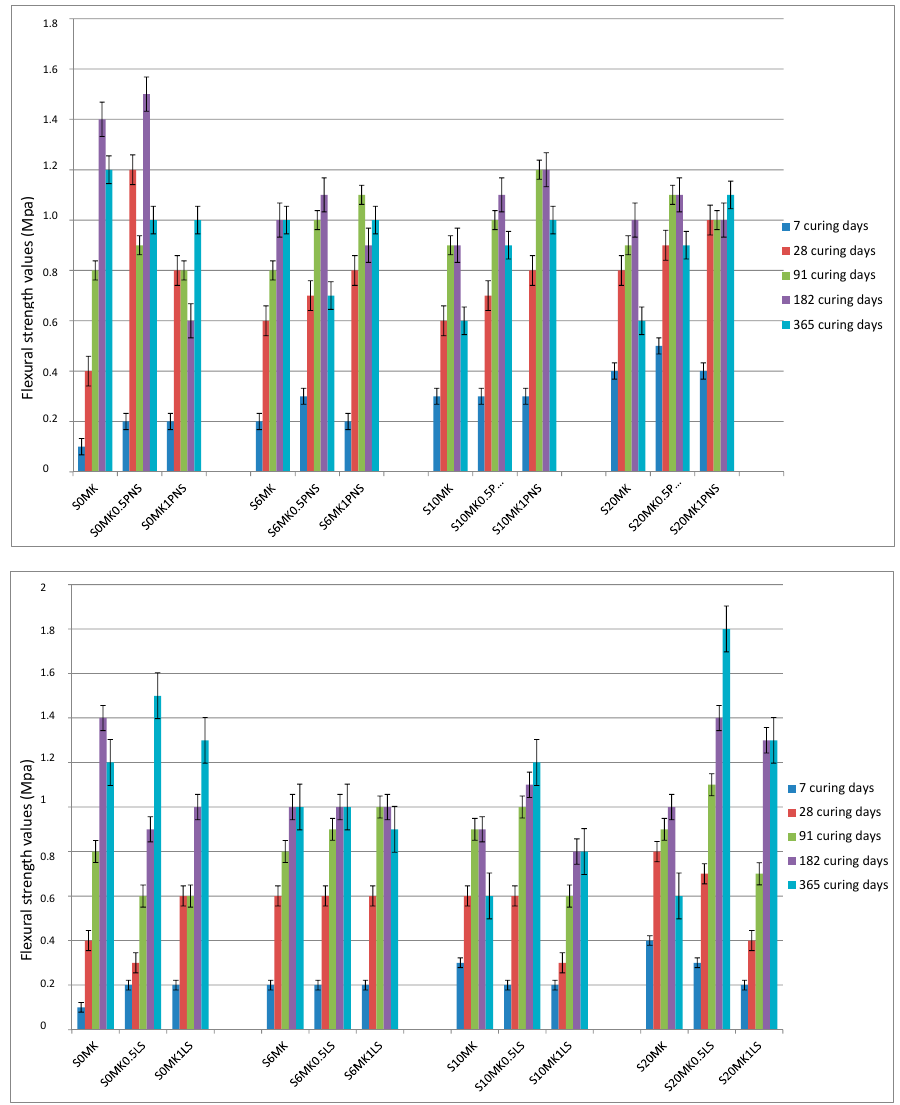
Figure 6. Flexural strength results of the grouts. PNS ( top ); and LS ( bottom ).